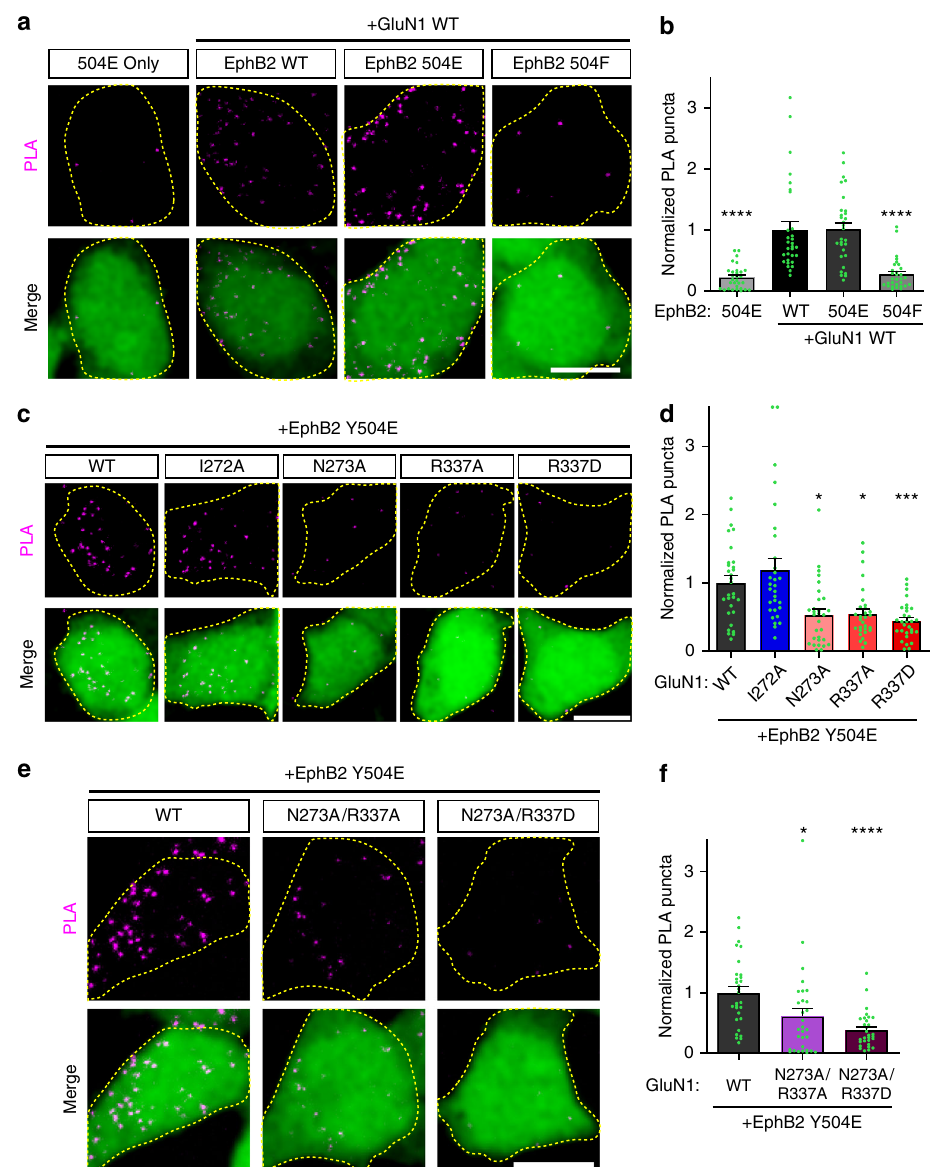
Fig. 6 EphB2 – GluN1 interaction in HEK293T cells is charge-dependent. a Representative images of PLA results in HEK293T cells. HEK293T cells were transfected with the indicated FLAG-EphB2 single point mutants (WT, Y504E, or Y504F), together with Myc-GluN1 WT, GluN2B, and EGFP. The upper panels show PLA signal alone. The lower panels are merged images of EGFP in green and PLA signal in magenta. Scale bar = 10 µ m. b Quanti fi cation of the effects of EphB2 mutants on PLA puncta number. PLA puncta number are quanti fi ed by counting the number of puncta per 100 µ m 2 in EGFP + cells and normalizing to the WT condition. (**** p <0.0001, ANOVA; n = 30 cells for each condition). c Representative images of PLA results in HEK293T cells. HEK293T cells were transfected with the indicated Myc-GluN1 single point mutants, together with GluN2B, FLAG-EphB2 Y504E, and EGFP. The upper panels show PLA signal alone. The lower panels are merged images of EGFP in green and PLA signal in magenta. Scale bar = 10 µ m. d Quanti fi cation of the effects of GluN1 mutants on PLA puncta number. PLA puncta number are quanti fi ed by counting the number of puncta per 100 µ m 2 in EGFP + cells and normalizing to the WT condition. (* p <0.05, *** p < 0.005, ANOVA; n = 30 cells for each condition). e Representative images of PLA results in HEK293T cells. HEK293T cells were transfected with the indicated Myc-GluN1 double point mutants, together with GluN2B, FLAG-EphB2 Y504E, and EGFP. The upper panels show PLA signal alone. The lower panels are merged images of EGFP in green and PLA signal in magenta. Scale bar = 10 µ m. f Quanti fi cation of the effects of GluN1 mutants on PLA puncta number (* p = 0.0219, **** p < 0.0001, ANOVA; green dots represent n = 30 cells for each Impact on synaptic stability of the NMDAR . Disrupting the (Fig. 7a, d, * p < 0.05, ANOVA). In contrast, the N273A/R337D EphB2 – NMDAR interaction by mutating the hinge region of GluN1 charge mutant was signi fi cantly less well colocalized GluN1 results in increased mobility of NMDARs found in den- with EphB2 compared to WT GluN1 (Fig. 7a, d, * p < 0.05, dritic spines. We next asked whether the GluN1 N273A/R337D ANOVA). Together, these data suggest that the positive surface charge mutant is suf fi cient to increase the mobility of the charge provided by N273 and R337 is necessary for the NMDAR in dendritic spines. To test this, neurons were trans- EphB – NMDAR interaction in neurons. fected with either WT EGFP – GluN1, EGFP – GluN1 I272A, or